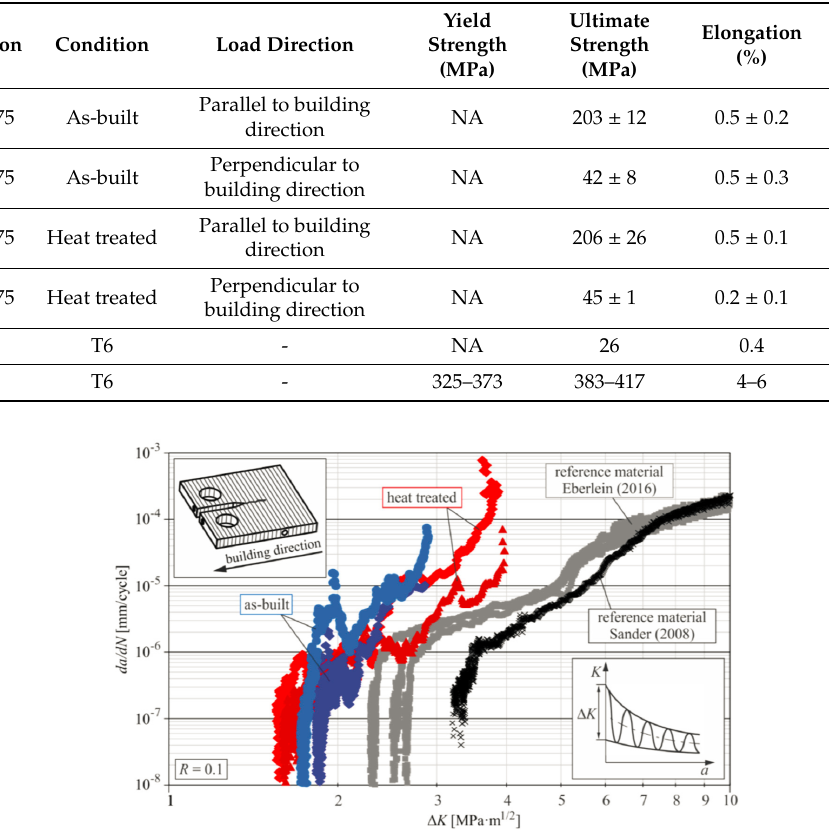
Figure 65. Fatigue crack growth curves for SLM-processed EN AW-7075 in different conditions. The crack plane and crack growth are parallel to the building direction. Data for conventionally processed reference material by Sander (2008) and Eberlein (2016) are displayed in black and grey color [204].